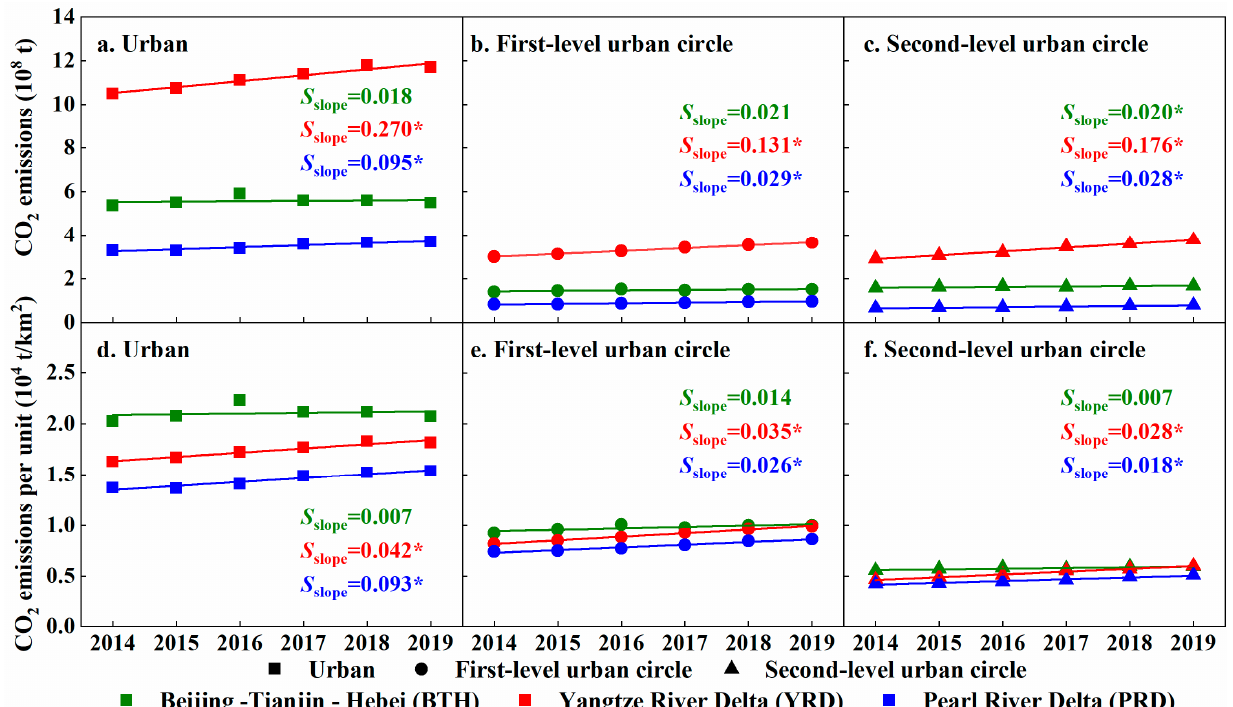
Figure 8. CO 2 emissions and CO 2 emissions per unit within cities. The fitting curve indicated the temporal trend of CO 2 emissions in three urban circles for each urban agglomeration and S slope indicated the slope of energy CO 2 emissions from 2014 to 2019. The star behind S slope value mean the significance test of trend was passed ( p < 0.05).